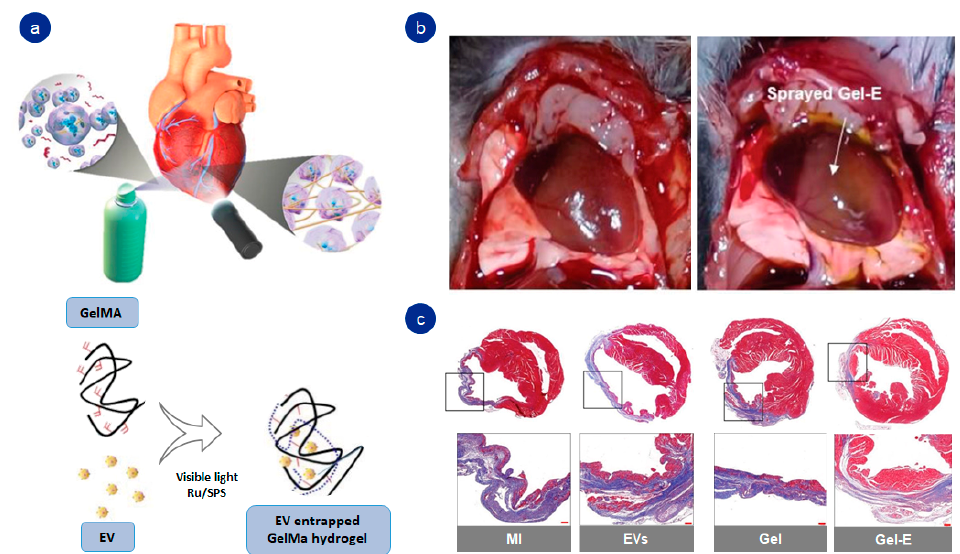
Figure 5. Functionalized gelatin-based hydrogel: ( a ) graphic representation of sprayable hydrogel; ( b ) in vivo implantation of hydrogel into the myocardial tissue; ( c ) trichrome staining results after 28 days of hydrogel implantation. Adapted with permission from Tang et al. [59]. Advanced Healthcare Materials, published by John Wiley and Sons, copyright 2021.